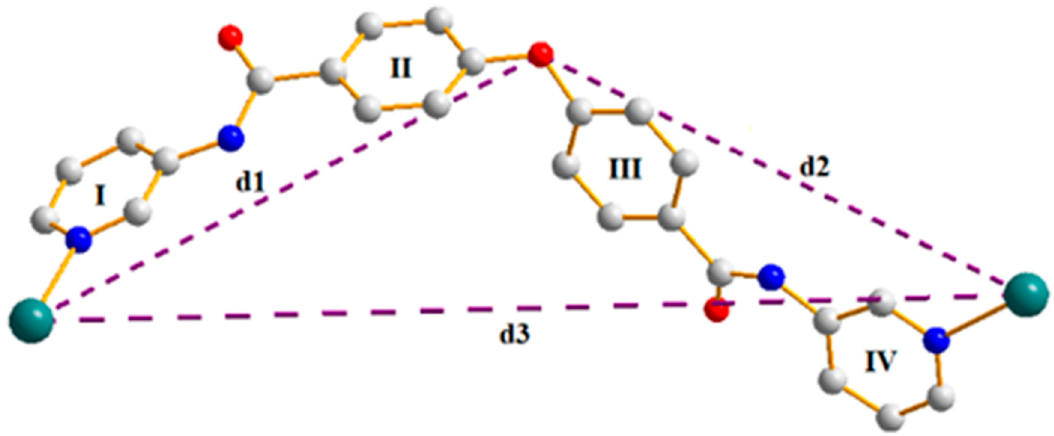
Figure 7. A schematic diagram defining the distances and the dihedral angle.